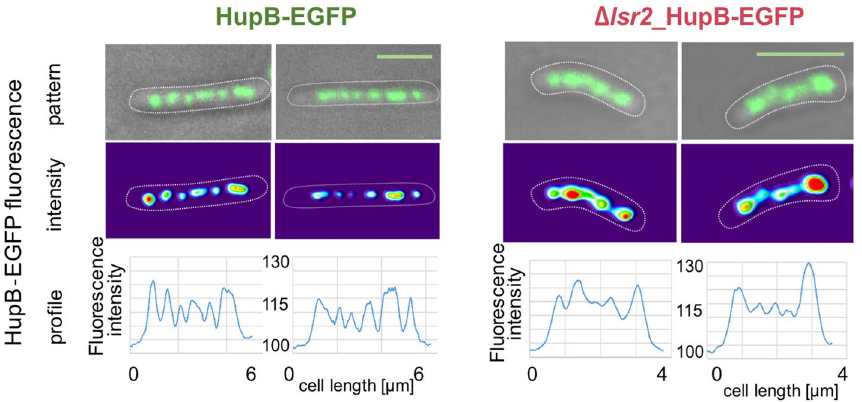
Figure 2. Influence of lsr2 deletion on global chromosome organization. The nucleoid was visualized using the HupB-EGFP fusion protein. Micrographs and fluorescence intensity profiles of the two representative cells of